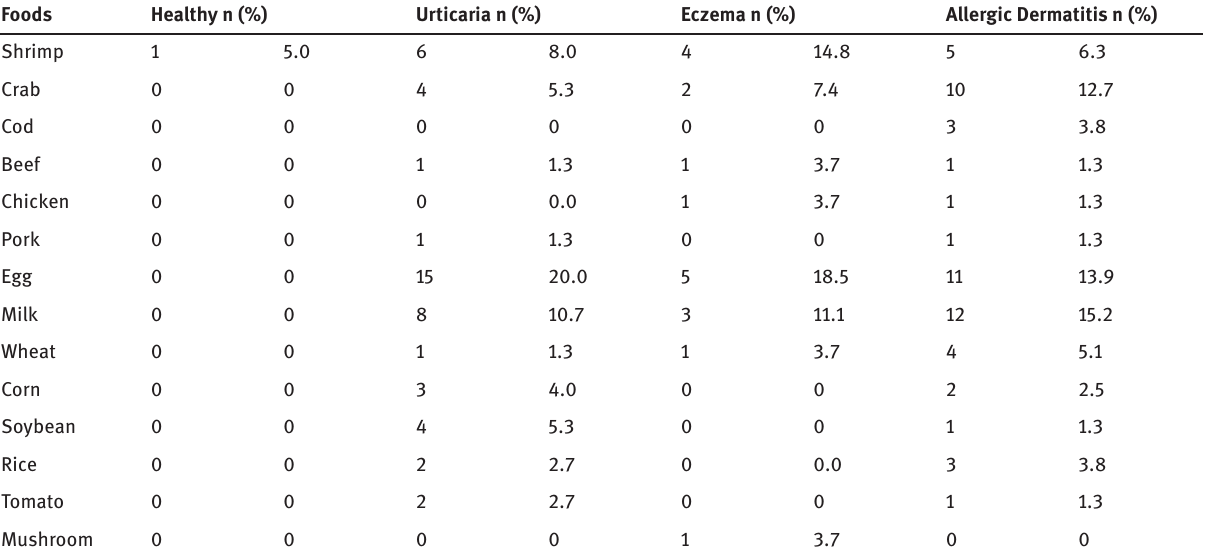
Table 3: IgG antibody positiv rate of 14 kinds of foods in the serum of healthy subjects and allergy dermatosis patients. Foods